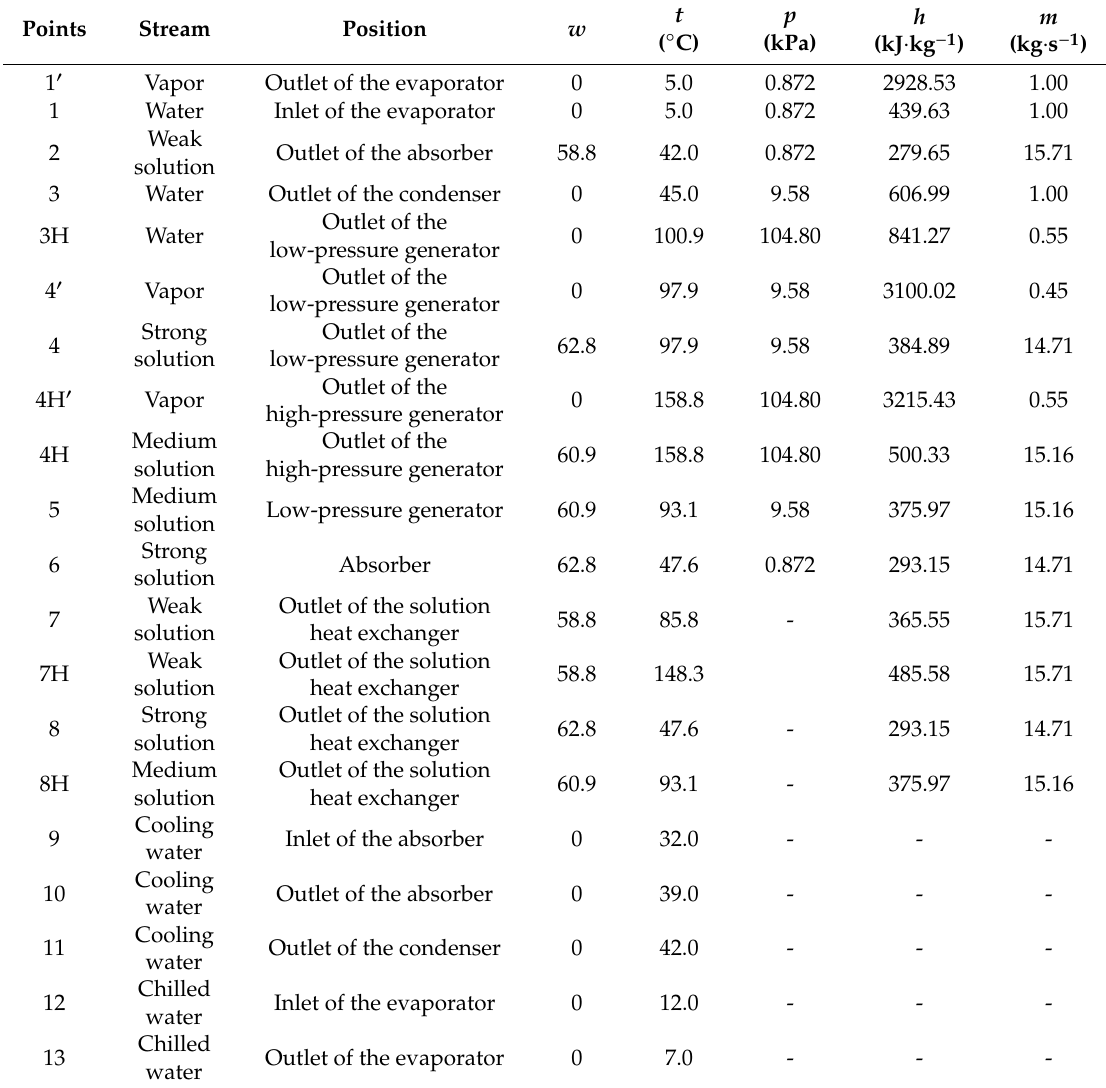
Table 4. State parameters of streams in the cycle with LiBr / H 2 O.